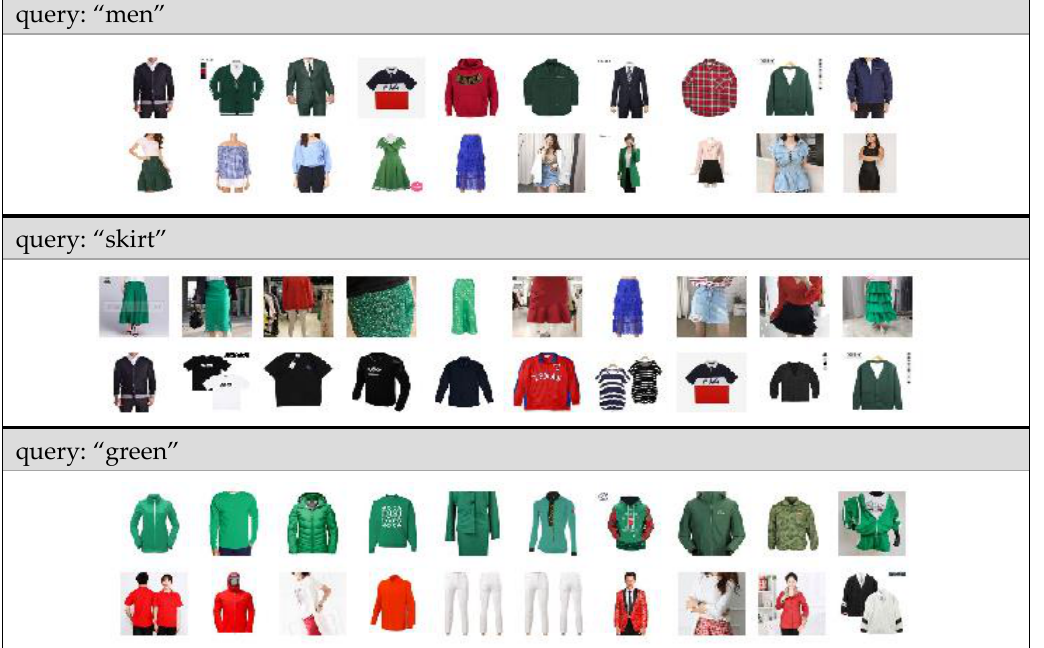
Figure 8. Fashion product search results for queries using a single keyword.